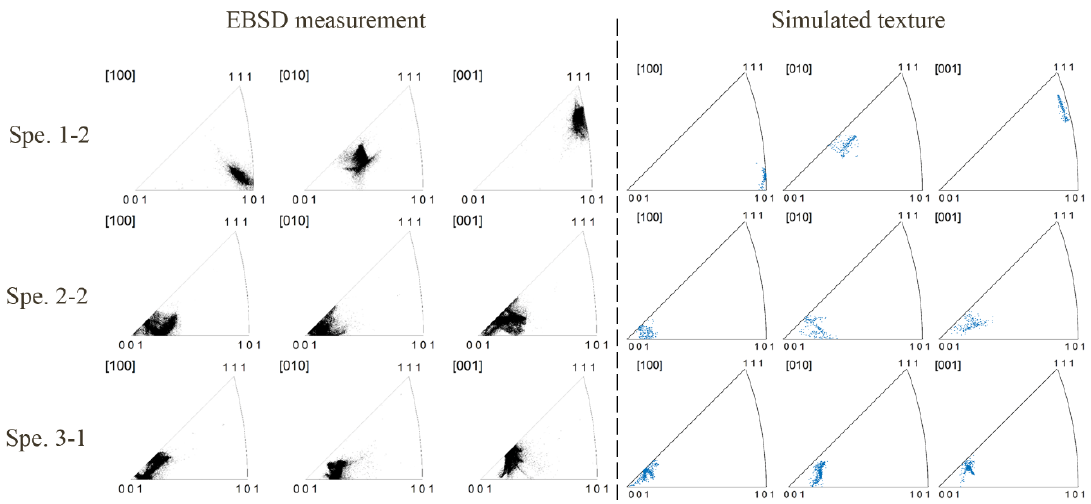
Figure 6. Comparison between EBSD observed microstructures in the specimen neck region and numerically calculated results after tensile deformation. Only the specimens with larger neck elongation in each initial orientation were presented to save space.